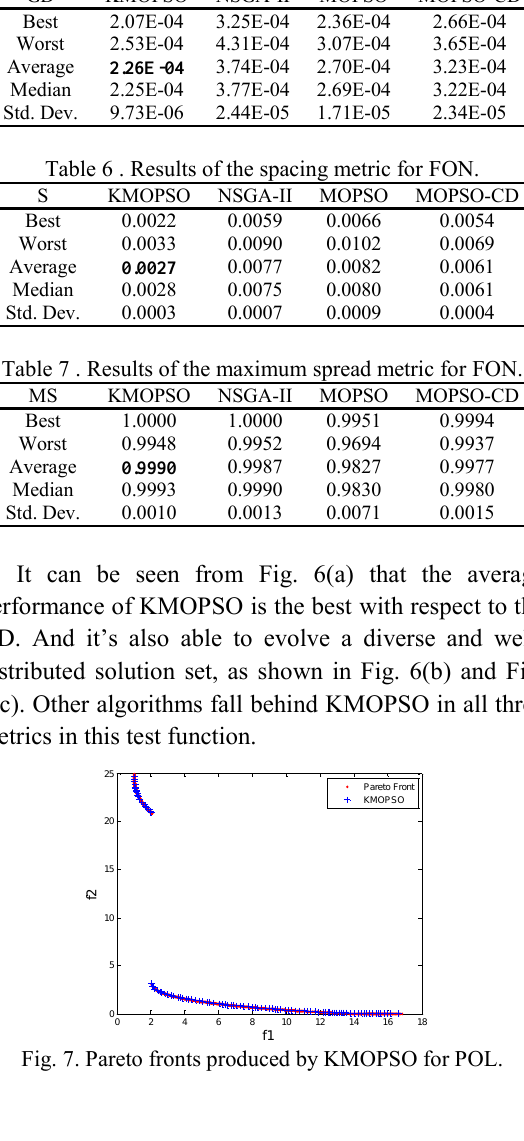
Fig. 9. Pareto fronts produced by KMOPSO for